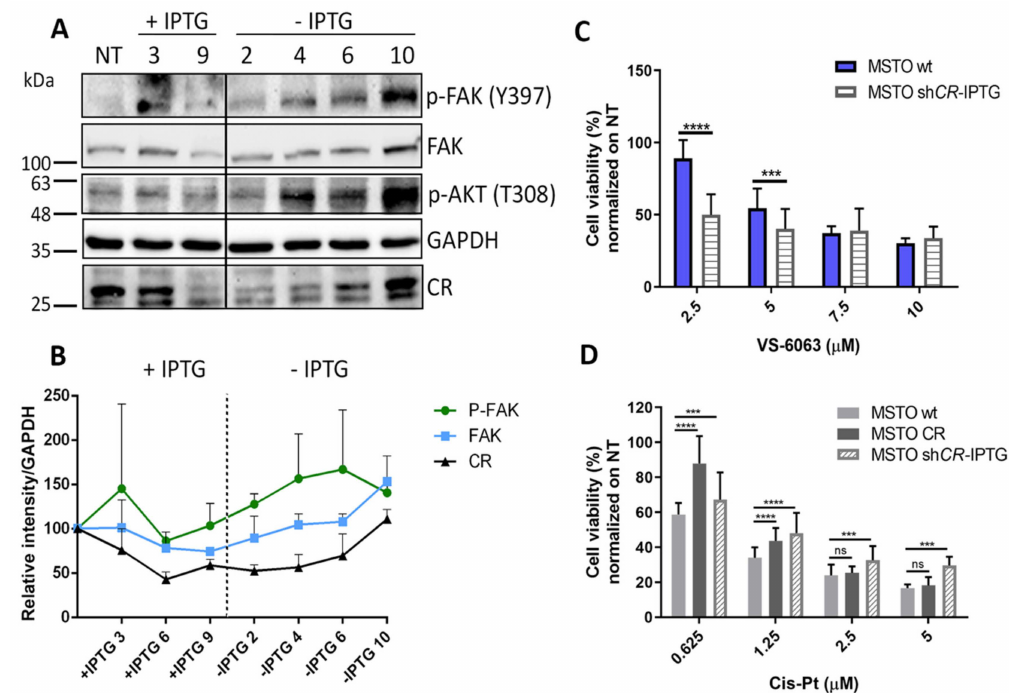
Figure 3. E ff ect of CR downregulation on di ff erent proteins and cell viability after treatment with VS-6063 and Cis-Pt. ( A ) Protein levels of p-FAK (Tyr 397 ), FAK, p-Akt (Thr 308 ) and CR measured at di ff erent time points during IPTG induction and IPTG removal. Levels of p-FAK (Tyr 397 ) and FAK are decreased after 9 days of IPTG induction and subsequent CR depletion; levels are restored after IPTG removal and CR increases to pre-IPTG levels (10 days IPTG removal). P-Akt (Thr 308 ) protein levels remain unchanged in the presence of IPTG; during IPTG removal p-Akt (Thr 308 ) protein levels increase considerably. GAPDH was used as loading control. Protein size markers are shown on the left of the figure. ( B ) Normalized (to GAPDH) expression levels of FAK, p-FAK (Tyr 397 ), and CR in MSTO-shCALB2-IPTG treated for nine days ( + IPTG) and after IPTG removal (-IPTG) for 10 days suggest a biological link of both proteins with CR levels. ( C ) Cell proliferation / viability measured with the MTT assay after treatment of MSTO-wt and MSTO-shCALB2-IPTG cells with the FAK inhibitor VS-6063 for 72 h. ( D) MTT signals (proliferation / viability) measured after 72 h of treatment with di ff erent concentrations of Cis-Pt ranging from 0.625 µ M to 5 µ M in MSTO-wt, MSTO-CR and MSTO-shCALB2-IPTG (induced) cells ( n = 4 independent experiments; * p ≤ 0.05, ** p ≤ 0.01, *** p ≤